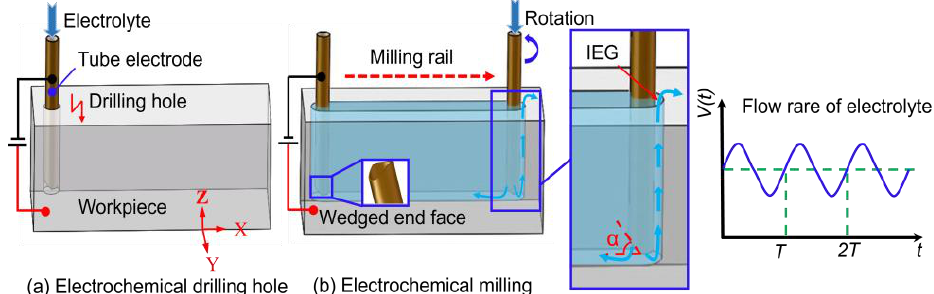
Figure 1. The schematic diagram of EC-milling of DNG with a wedged end face tube electrode. ( a ) Electrochemical drilling hole, ( b ) Electrochemical milling.